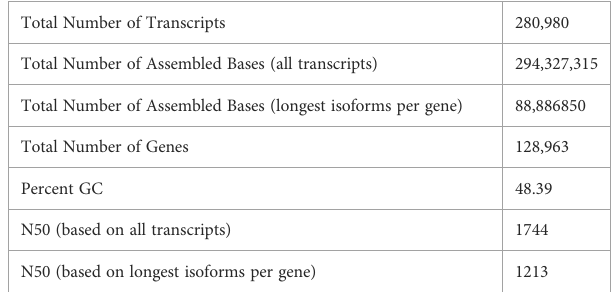
TABLE 1 A summary of RNA-Seq data.